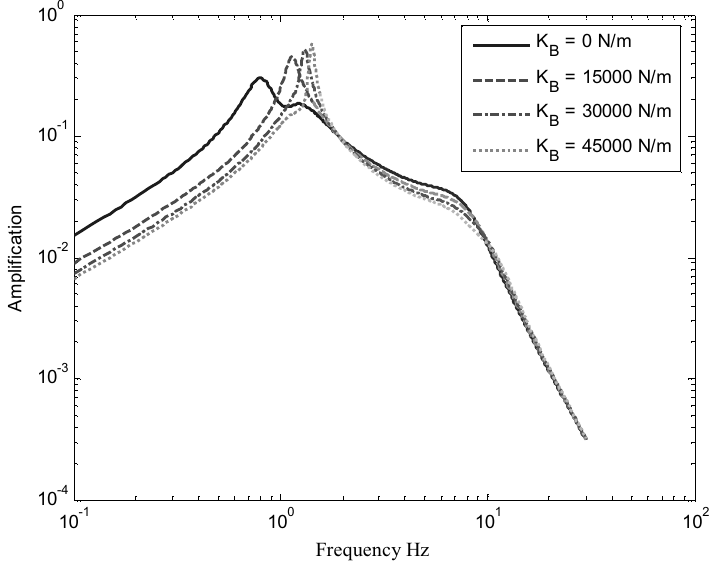
Fig. 3. Suspension deflection of passive suspension with passive ARB.